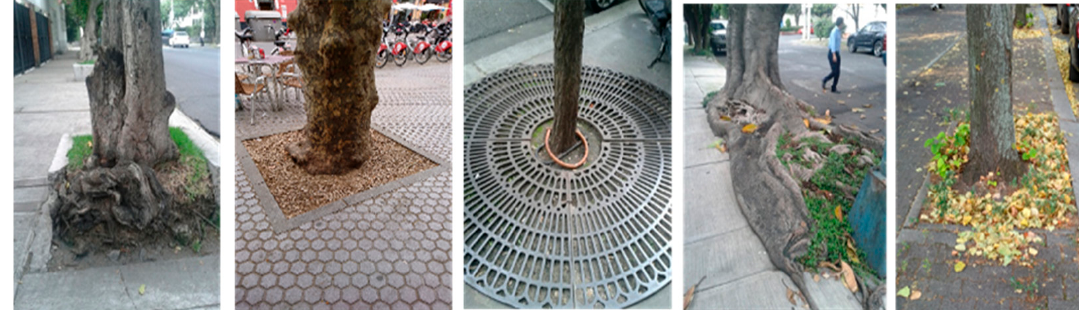
Figure 1. Examples of urban street-tree catchments, as found in Mexico City, Paris, NYC, Sydney, and Berlin.